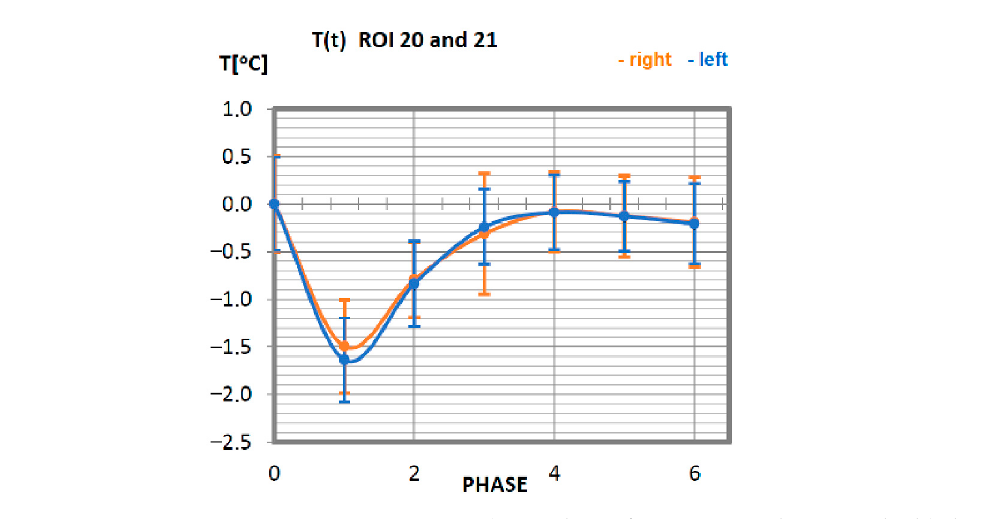
Figure 12. Temperature time (0 to 6 phase of training according to methods) changes of the latissimus dorsi muscle of the thigh obtained before and after training using a rowing ergometer for the studied group of athletes.